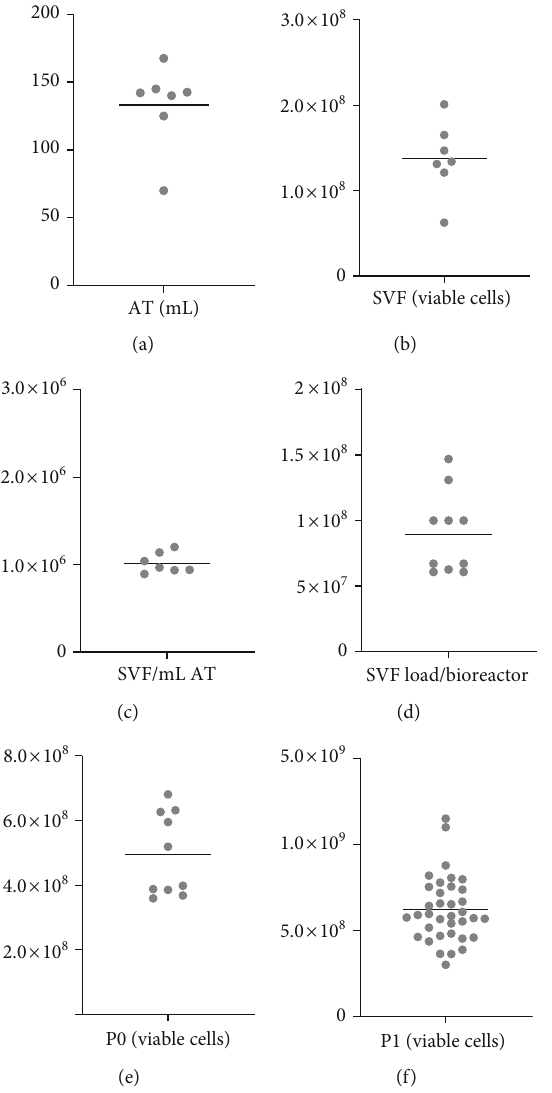
Figure 2: Overview of yield. (a) Volume of adipose tissue (AT) processed per donor ( n = 7 ). (b) Number of stromal vascular fraction (SVF) isolated from AT ( n = 7 ). (c) Yield SVF per ml AT. (d) Number of SVF loaded into the bioreactor ( n = 10 ). (e) ASC P0 harvested per batch (n = 10 ). (f) ASC P1 harvested per batch ( n = 36 ). The line represents the mean